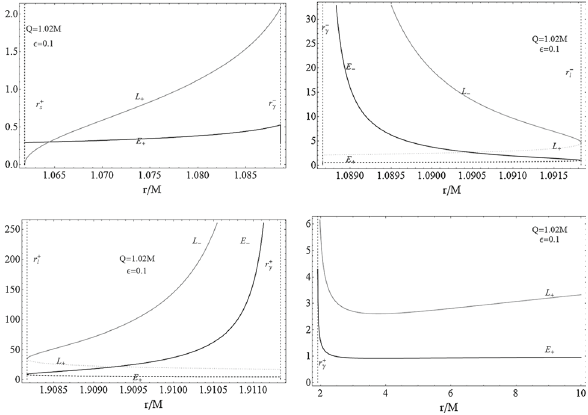
√ Fig. 6 Class : M < Q ≤ 5 /( 2 6 ) M and 0 < (cid:2) ≤ (cid:9)(cid:9) (cid:2) − . Param- eter choice is as follows: Q = 1 . 02 M and (cid:2) = 0 . 1. Then (cid:9)(cid:9) (cid:2) − = 0 . 215376, r + s = 1 . 06185 M , r − γ = 1 . 08866 M , r + γ = 1 . 91134 M , = 1 . 09183 M , and r + = 1 . 90817 M . Circular orbits exist with r − l l angular momentum L = L − ( gray curve ) and energy E = E − ( black curve ) in r + s < r < r − γ ; L = 0 at r = r + s ( upper left plot ); L = L ± ≤ r < r + in r − γ < r ≤ r − ( upper right plot ) and in r + γ ( bottom left l l plot ); L = L − in r ≥ r + γ ( bottom right plot ). The angular momentum L + is represented by a gray dotted curve and the energy E + by a black dashed curve